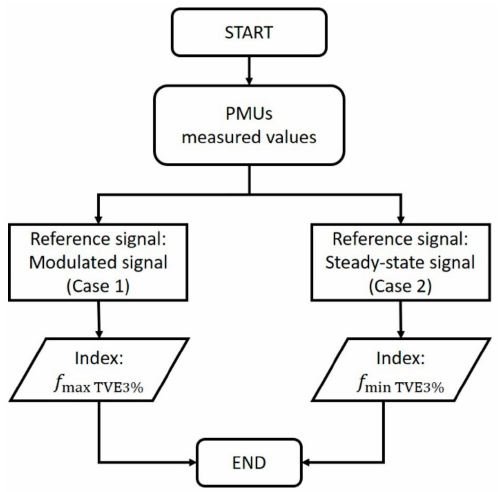
Figure 5. Flow chart of the evaluation